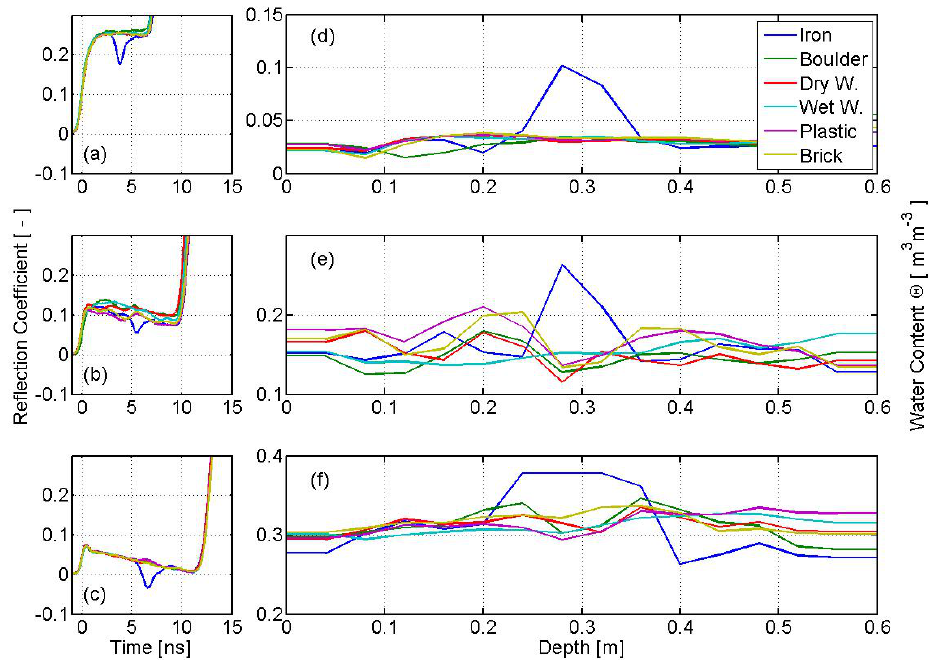
Fig. 8. Reflectograms and inverted soil moisture profiles with an iron block, dry and wet wood, PVC block, brick and boulder with a volume of approximately 1.5l at a depth of 0.30m. All probes were measured with ideal geometry. The mean soil moisture is about 0.04m 3 m − 3 , ( (a) and (d) , dry case) 0.16m 3 m − 3 ( (b) and (e) , intermediate case) and 0.30m 3 m − 3 ( (c) and (f) , wet case). Wood is abbreviated to W. Table 7. Mean soil moisture observed with THETA probes and estimated with the different objects and the soil moisture in the area of the object.